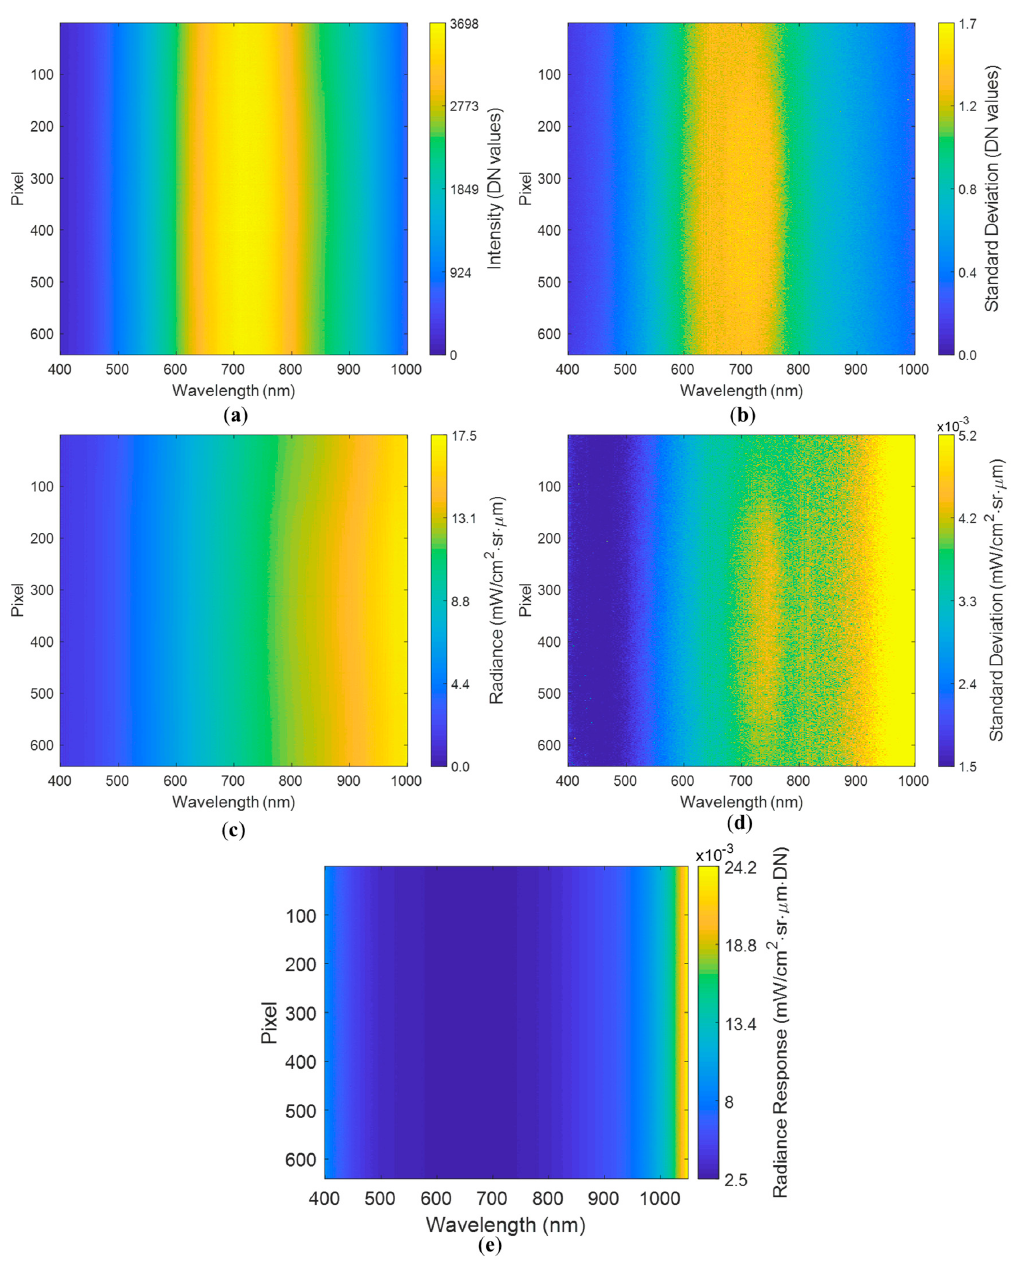
Figure 4. Spectral signature for the white reference with an exposure of 12.5 ms, showing ( a ) DN mean spectral signature, ( b ) standard deviation of the DN spectral signature, ( c ) radiance mean spectral signature, ( d ) standard deviation of the radiance spectral signature, and ( e ) Spectralon radiance response.